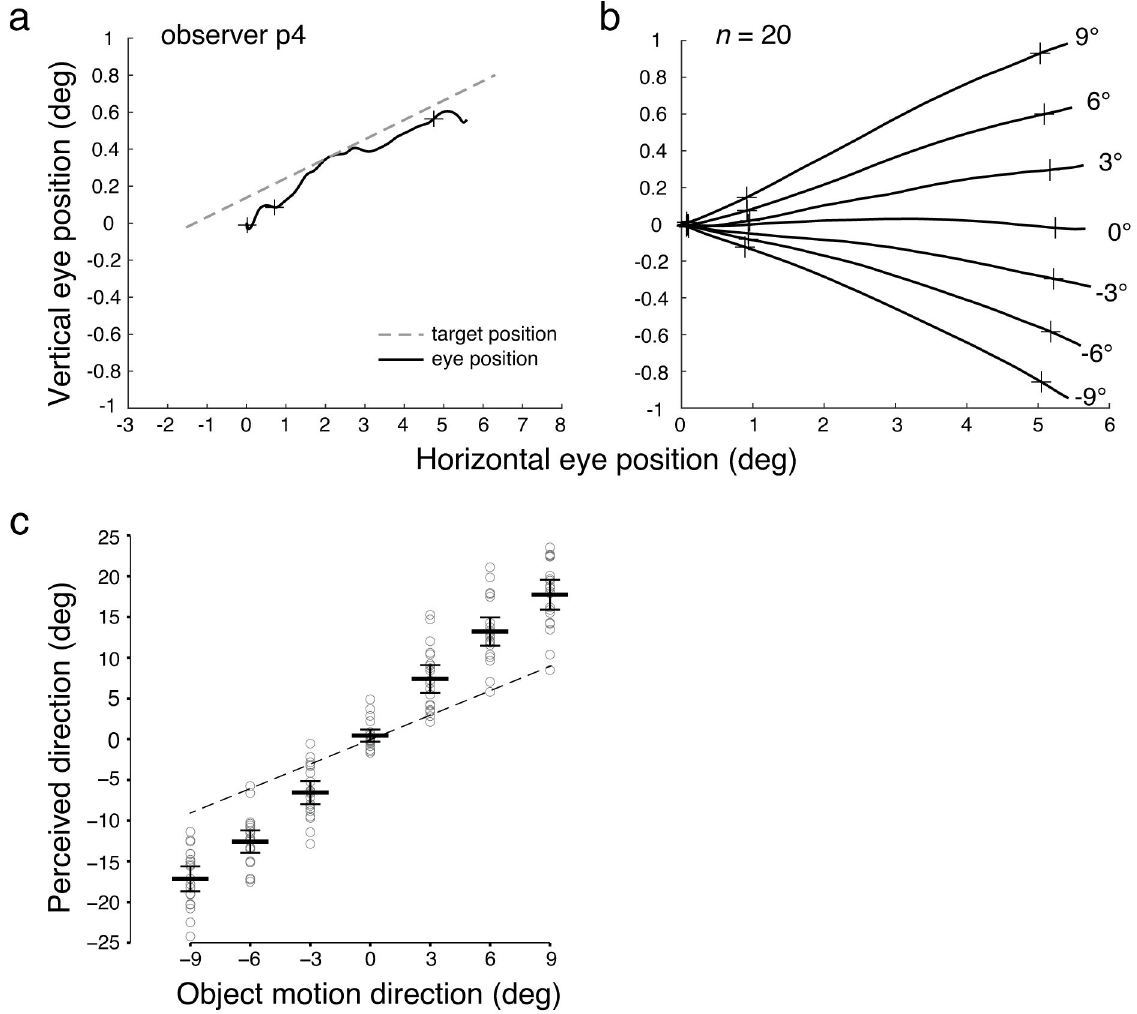
Fig 4. Eye position traces and perceived direction in the baseline internal motion condition. (a) Example eye position trace from one trial without internal motion from RDK onset to RDK offset. The object motion direction (dashed line indicates trajectory of RDK center) is 6˚. From left to right, the crosses indicate time points of pursuit onset, and the start and end of steady-state phase analysis window, respectively. (b) Average eye position traces across observers in the baseline internal motion condition. All traces are aligned to start from RDK onset at location (0, 0), and end at RDK offset. Numbers denote the object motion directions. (c) Perceived direction in the baseline condition averaged across observers ( n = 20). Horizontal bars indicate mean perceived direction across observers, and error bars indicate the 95% CI. Circles indicate the mean perceived direction of individual observers. The dashed line indicates the identity line. If the perceived direction was accurate without overestimation, data should fall on the identity line. CI, confidence interval.